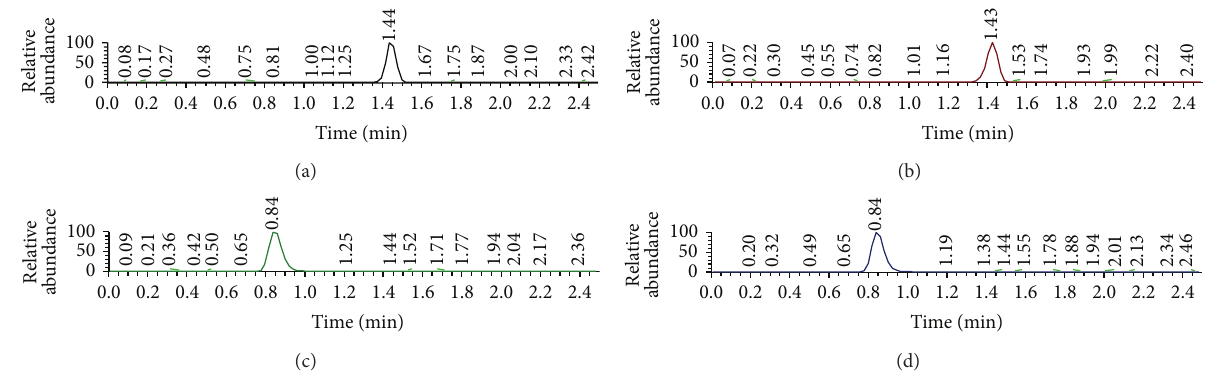
Figure 4: The LC-MS/MS chromatograms of BH4 (a), AACA (b), dopamine (c), and dopamine-D 4 (d) using Polar-Imidazole (2.0 × 150 mm; i.d., 3 𝜇 m) and mobile phase ACN: DW (75: 25, v/v, 10 mM ammonium formate).